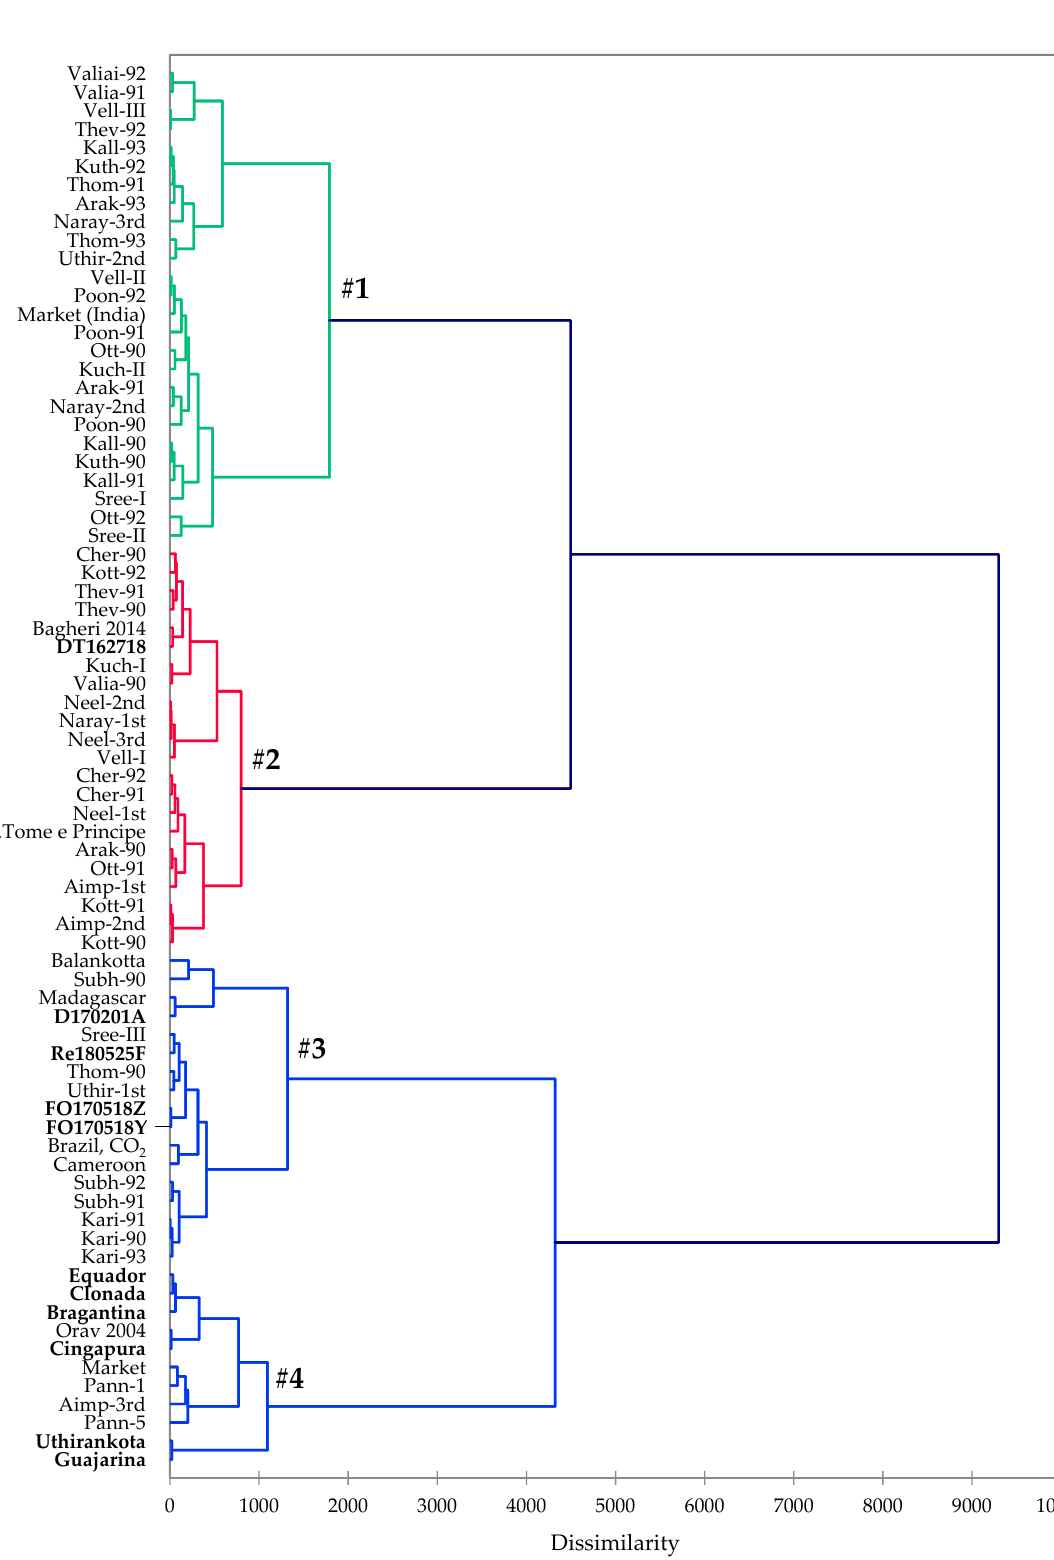
Figure 1. Dendrogram obtained from the agglomerative hierarchical cluster analysis of Piper nigrum oils. Entries in bold font are from this study.